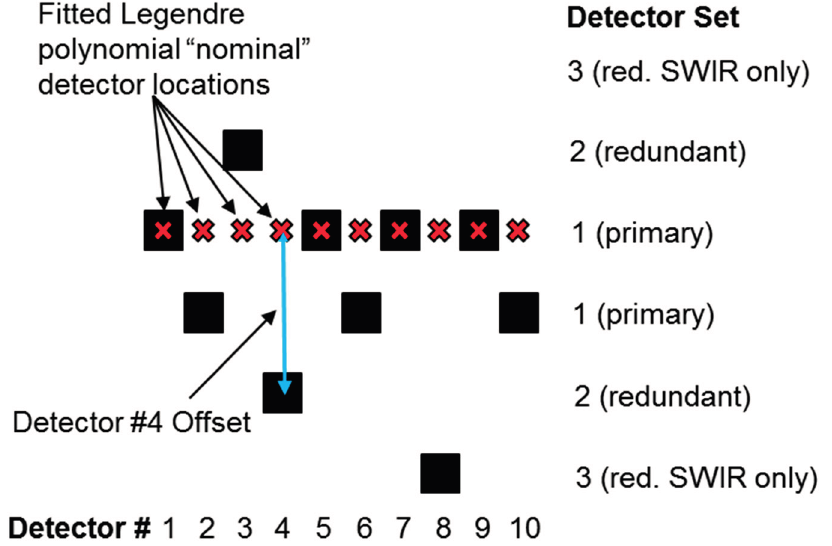
Figure 4. Using the example active detector pattern from Figure 3 above, red X’s indicate the ideal detector locations represented by the operational Legendre polynomial line-of-sight model. The Legendre polynomials model the trailing row of primary detectors with the departures of the actual detector locations from these ideal locations being captured in a detector offset